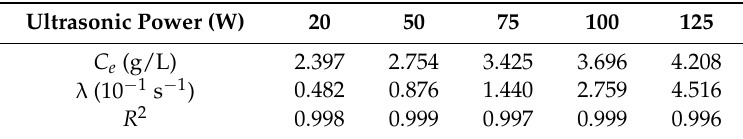
Table 1. Parameters of Kinetic model of glycyrrhizic acid from Glycyrrhiza uralensis with different ultrasonic powers.